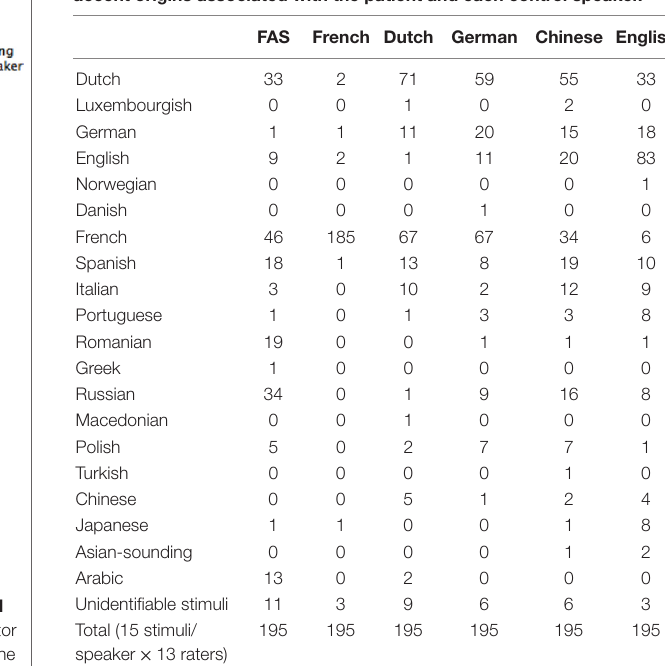
taBLe 9 | perceptual accent attribution experiment: number of different accent origins associated with the patient and each control